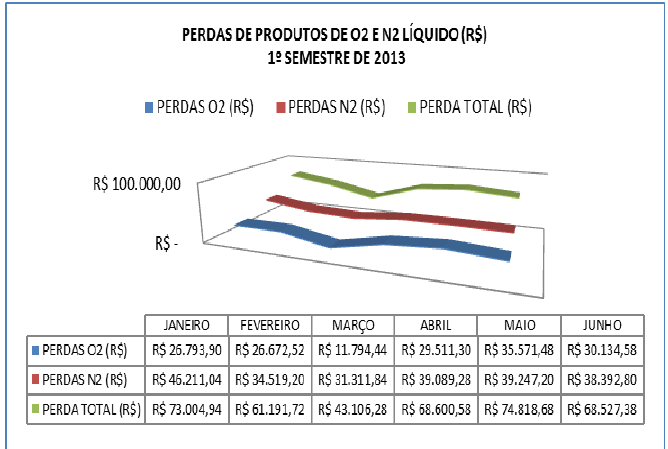
Figura 8. Perdas de produtos de 0 de 2013.